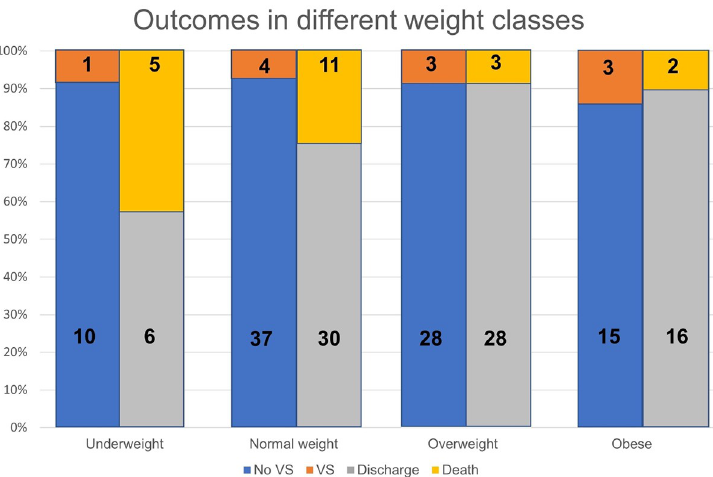
Fig 2. Outcomes among different BMI classes. Abbreviations: BMI, body mass index ; VS, ventilation support . Numbers in bold indicate absolute number of patients.